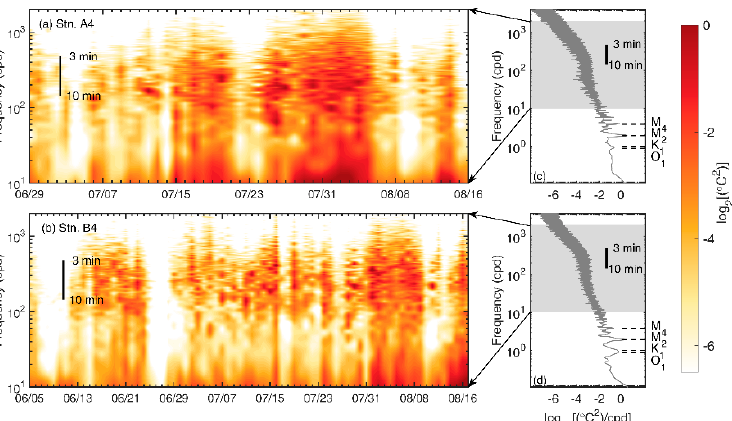
Figure 4. Temperature–frequency spectra of daily temperature variations at ( a ) Stn. A4 and ( b ) Stn. B4. The frequency spectra during the two–month–long observations at ( c ) Stn. A4 and ( d ) Stn. B4. For reference, the frequencies of the essential components are indicated by horizontal dashed lines.